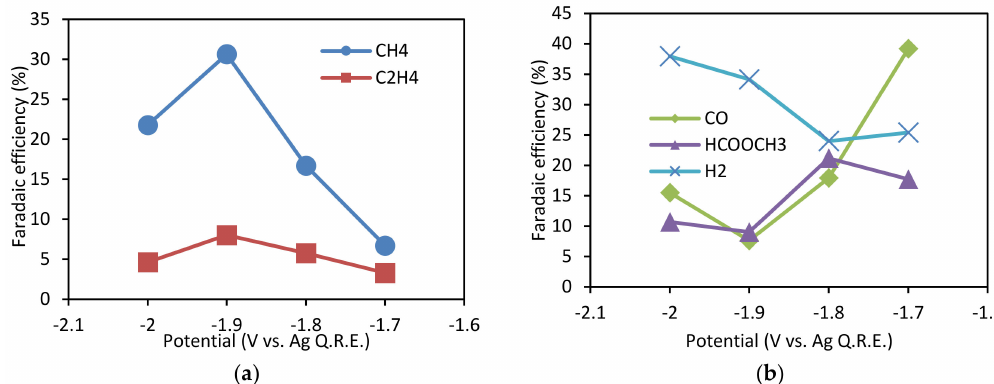
Figure 5. Influence of potential on the Faradaic efficiencies of products during the electrochemical reduction of CO 2 at Cu 2 O/carbon black electrode in NaCl/methanol. ( a ) hydrocarbons; ( b ) CO, HCOOCH 3 , and H 2 .